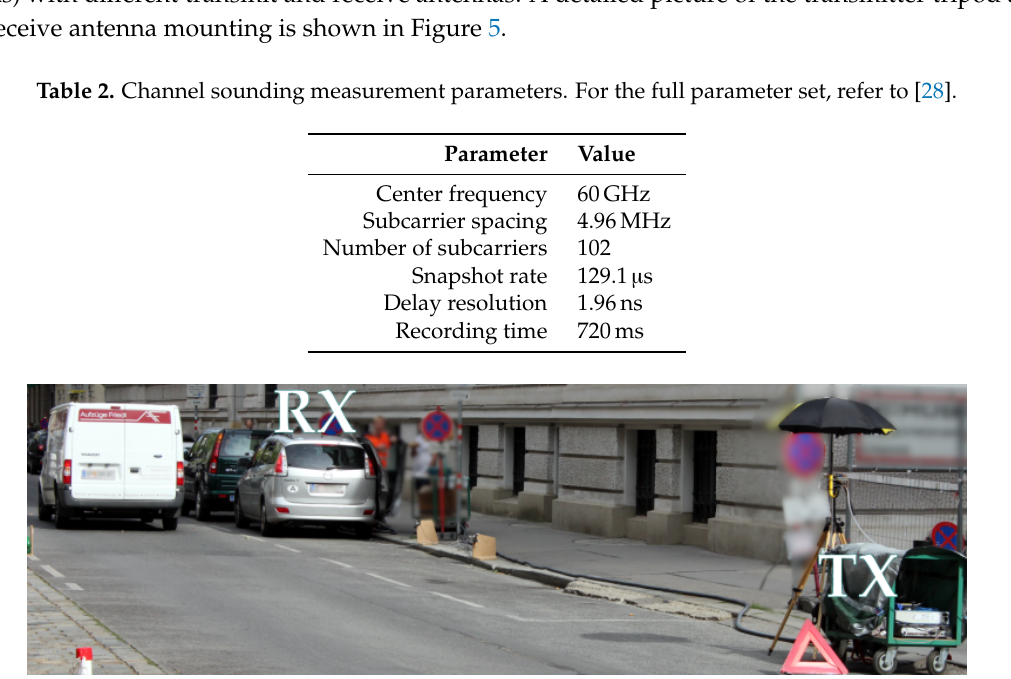
Figure 4. Photograph of the measurement site. The transmitter and receiver are static and urban street traffic is driving by.